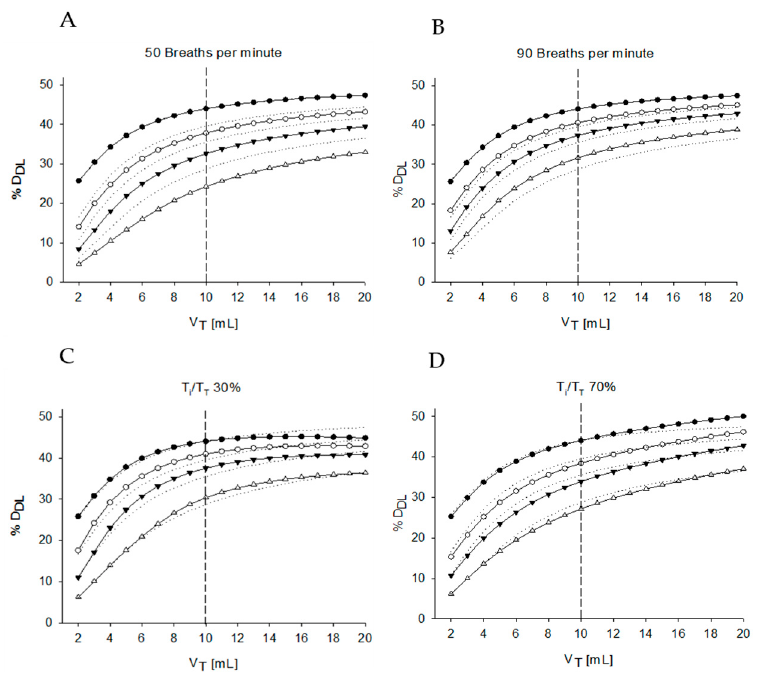
Figure 6. %D DL over V T evaluated varying one parameter at a time from the standard conditions: 50 breaths per minute ( A ), 90 breaths per minute ( B ), T i /T TOT = 30% ( C ), and T i /T TOT = 70% ( D ). V T = tidal volume, D DL = dose delivered to the lung, V neb = internal volume of the nebulizer, V uaw = volume of the conductive airways, T i /T T = inspiratory time over total time.